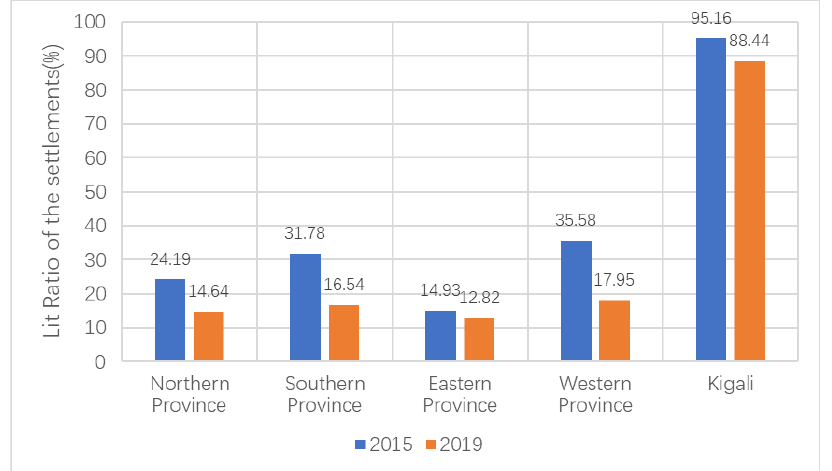
Figure 12. The lit ratio of each province in Rwanda in 2015 and 2019.